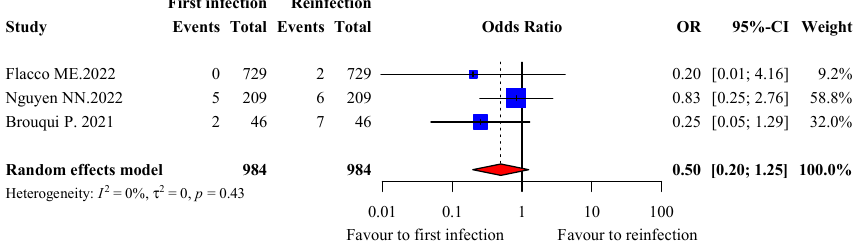
Figure 4. Forest plot of critical/severe disease during the first and second infection. A total of 7/16,616 (0.4%) reinfected patients died, with information reported